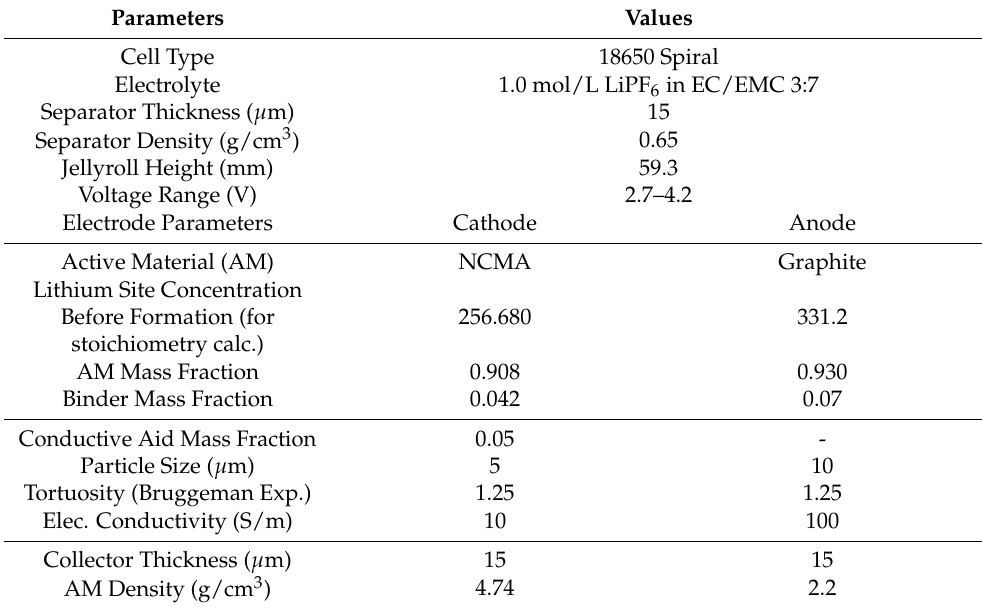
Figure 3. ( a ) 18650 cell assembly; ( b ) Equilibrium voltage curves of the positive electrode LiNi 0.89 Co 0.05 Mn 0.05 Al 0.01 O 2 and the Graphite negative electrode materials. Table 1. Parameters used to perform the BDS cycling simulations.